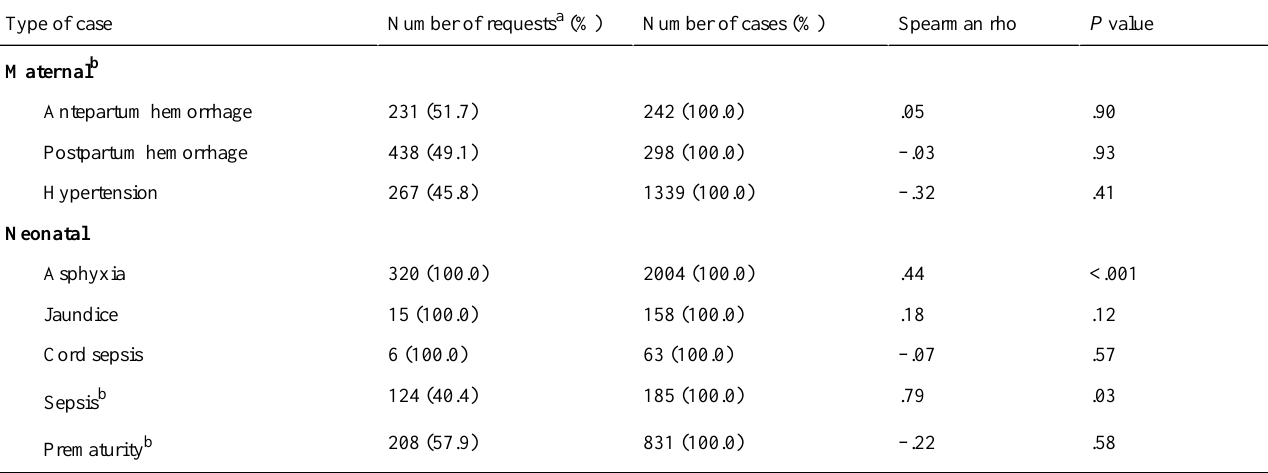
Table 3. Correlation between requests made to the intervention and actual number of cases recorded in health facilities.